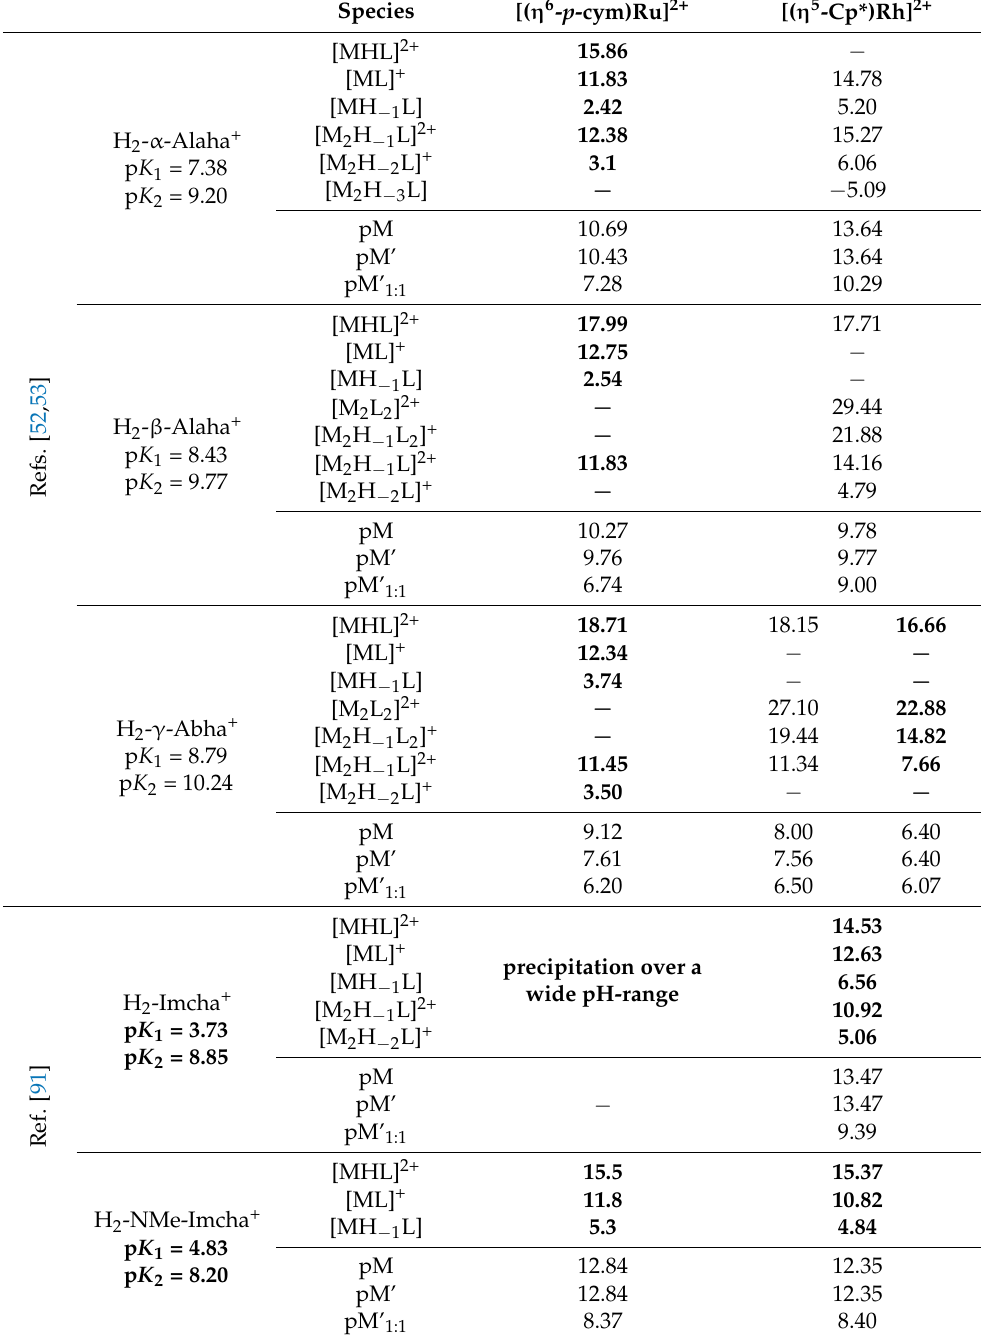
Table 3. Dissociation constants (p K a ) of the ligands and overall stability constants (log β ) a for their [( η 6 - p -cym)Ru] 2+ and [( η 5 -Cp*)Rh] 2+ complexes determined at t = 25 ◦ C, I = 0.20 M KCl (values in bold) or KNO 3 , as well as the derived constants: pM, pM’, and pM’ 1:1 . Species [( η 6 - p -cym)Ru]